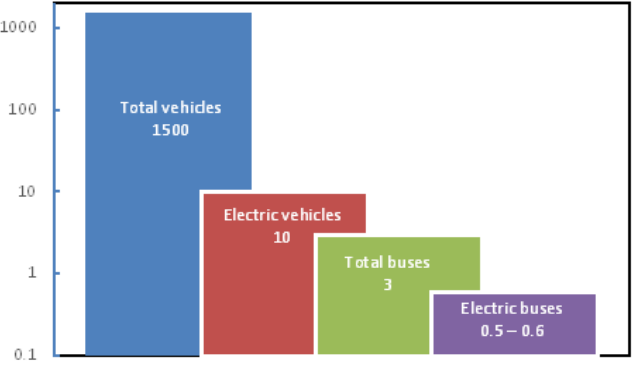
Figure 3. World numbers of vehicles, millions.